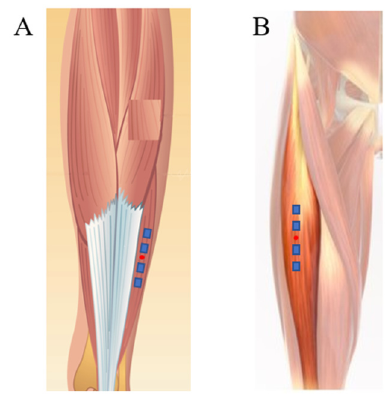
Figure 2. Accelerometers of interest position in relation to the impact point.